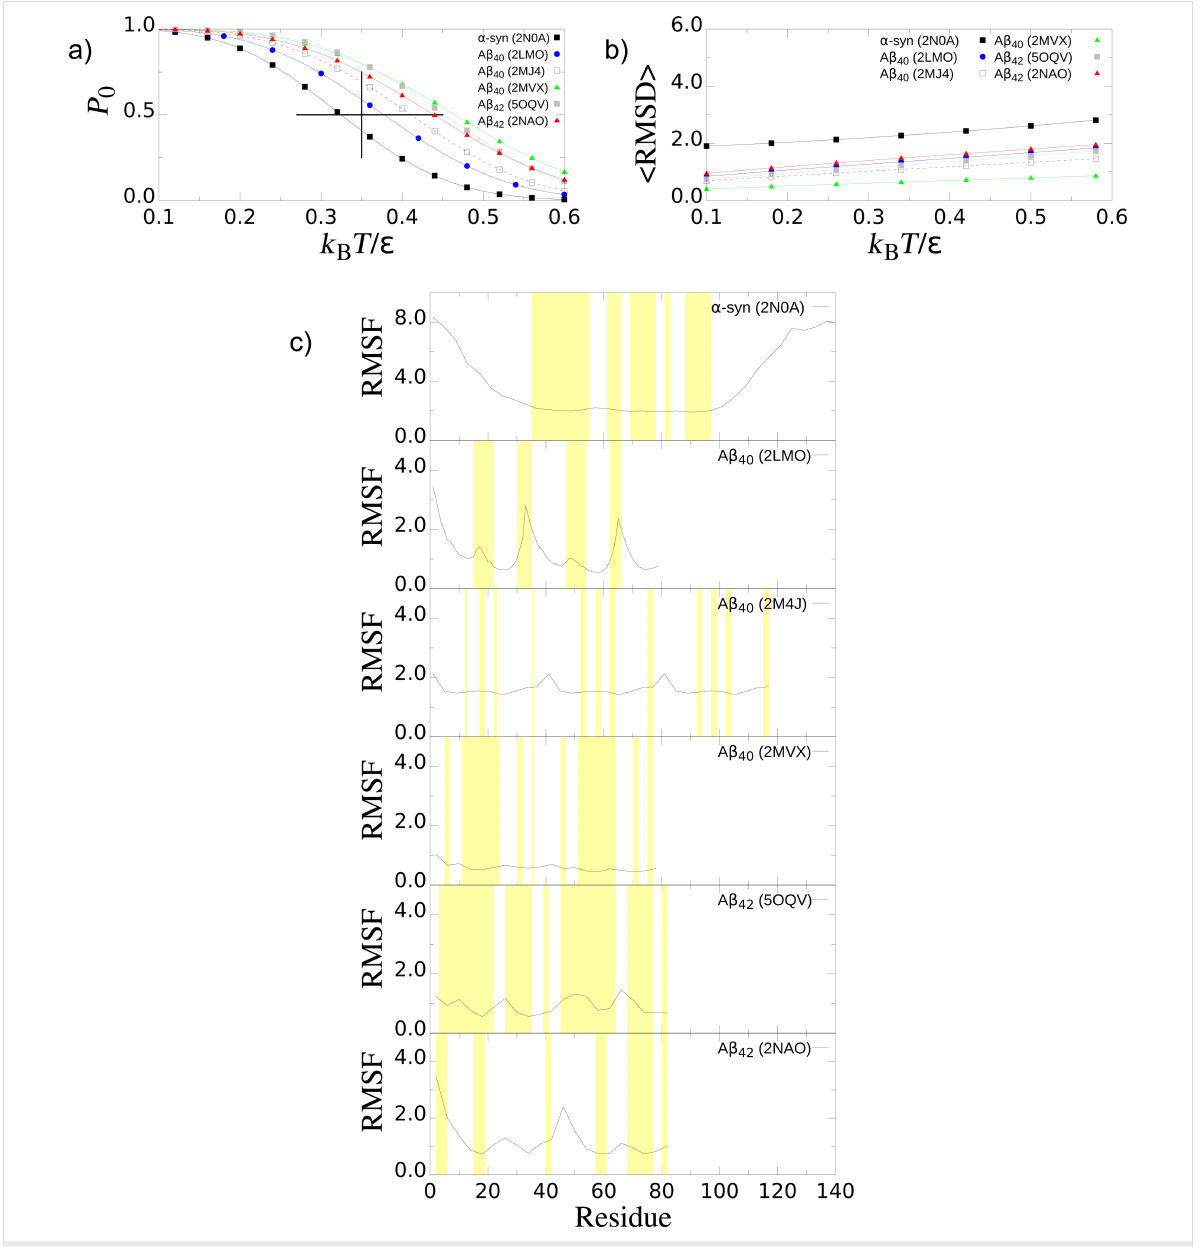
Figure 7: Thermodynamic properties of biological fibrils. (a) Probability of finding the fibrils in the native “fibril” state , P 0 , as a function of the tempera- ture. The vertical line indicates the room temperature equal to 0.35 ε / k B and the horizontal line the range of temperatures that offer thermodynamic stability in our model. (b) RMSD of the fibrils. (c) Root-mean-square-fluctuation (RMSF) at room temperature. The β -strand segments in each system are highlighted in